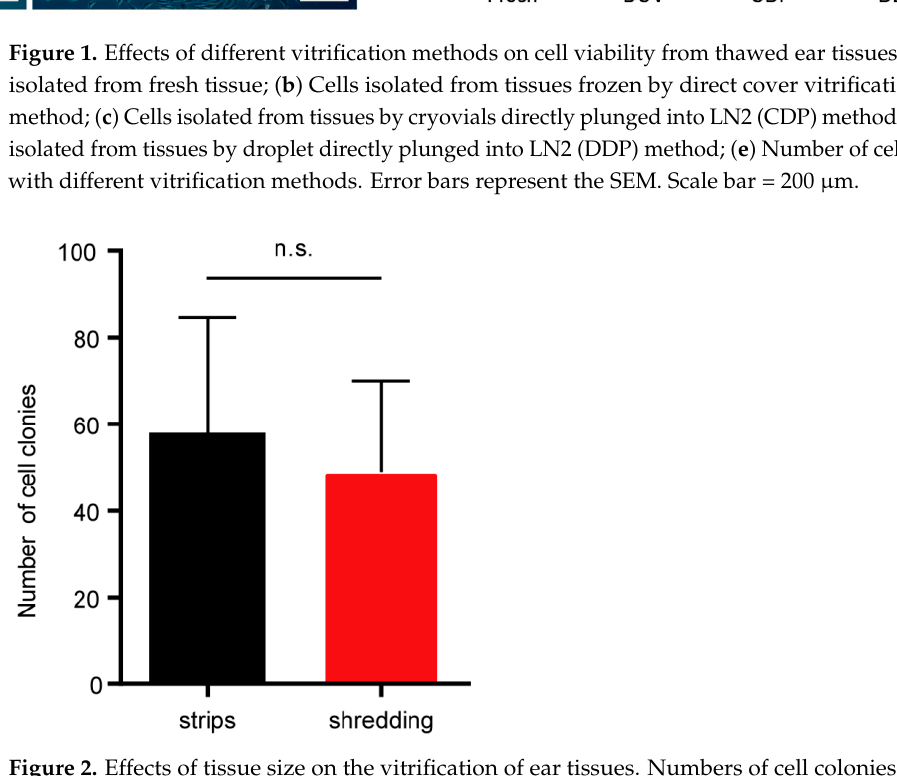
Figure 2. E ff ects of tissue size on the vitri fi cation of ear tissues. Numbers of cell colonies obtained from di ff erent sizes of frozen-thawed tissue. Error bars represent the SEM.